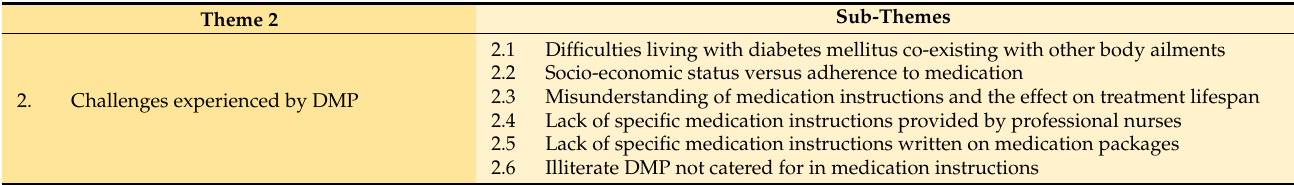
Table 3. Challenges experienced by diabetes mellitus clients